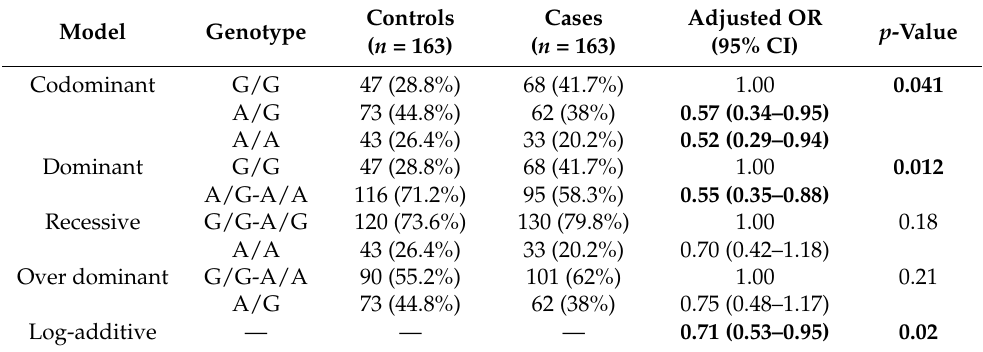
Table 3. Risk of systemic lupus erythematosus by genetic association models of miR-34a rs2666433 (A/G) genotypes.